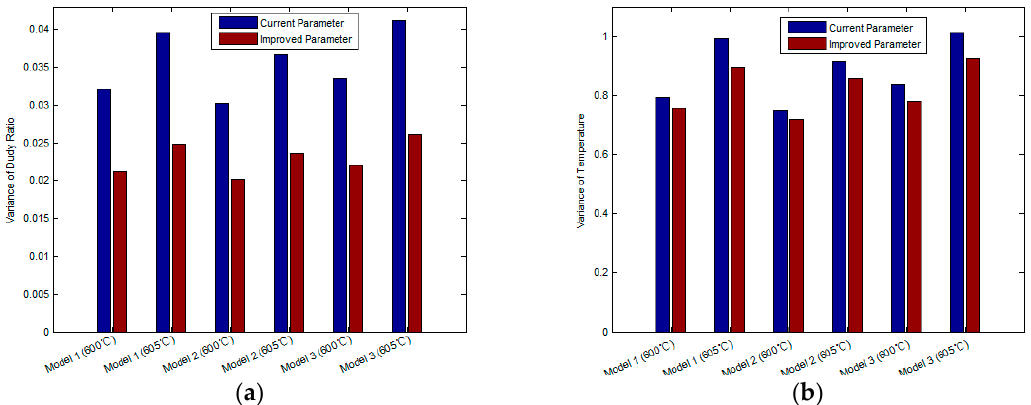
Figure 8. ( a ) The input variance comparison of the improved parameter and the current parameter. ( b ) The output variance comparison of improved parameter and current parameter.